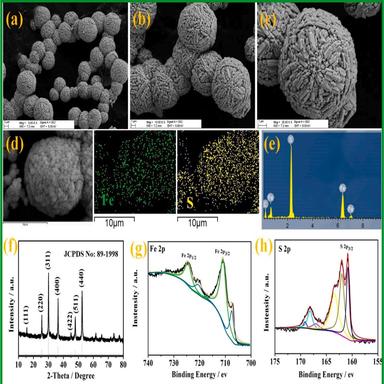
(a-c) FE-SEM images of the Fe3S4(150 °C) microspheres at different magnifications; (d-e) EDS images of the Fe3S4(150 °C) sample with SEM-EDS analysis showing the elemental mapping of Fe and S; (f) XRD pattern of the Fe3S4 (150 °C) sample; (g) Fe 2p high-resolution spectrum, and (h) S 2p high-resolution spectrum of the Fe3S4(150 °C) sample (the fitted curves are marked with color lines).